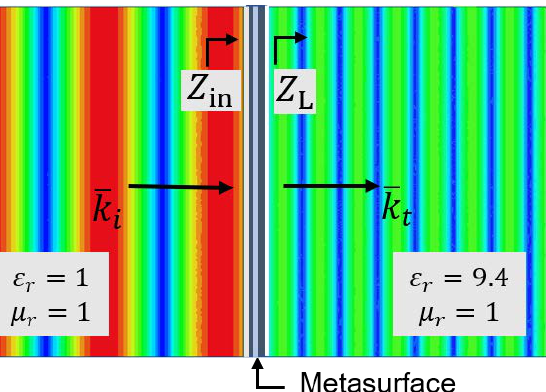
Figure 2. A metasurface at the interface between air and alumina half-spaces. The metasurface is used to impedance match a normally incident plane wave traveling from the region of air into the alumina.